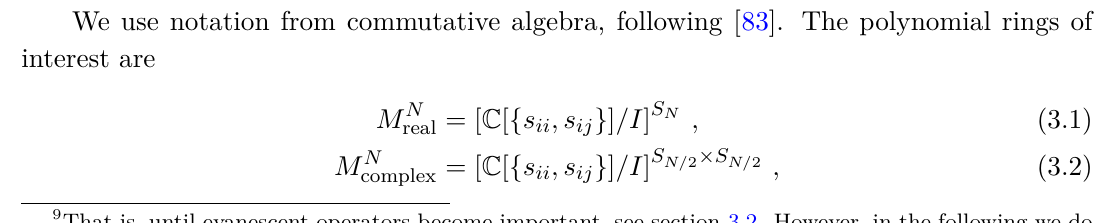
Figure 2 . The three types of objects in QFT calculations for which we discuss kinematic bases